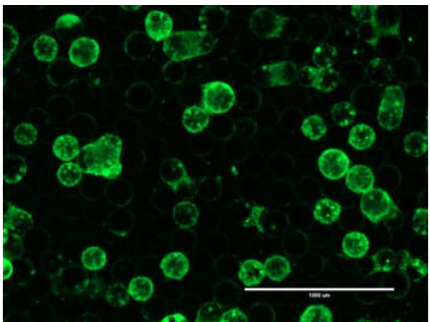
Figure 7: SYBRGreen stained hUC MSCs on Plastic Plus microcar- riers after 9 days of culture in 200 mL DMEM medium in a spinner culture at a seeding density of 8000 cells ⋅ cm −2 . The spinner culture was started with 100mL working volume and 2.5 g microcarriers. After 4 days a feed of 100 mL fresh medium and 2.5 g fresh microcarriers was performed to investigate a bead-to-bead transfer. The microcarriers are either totally confluent with cells or blank (scale bar = 1000 𝜇